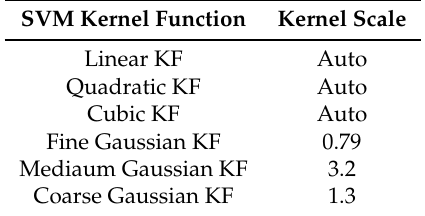
Table 2. Kernel Scale of support vector machine (SVM) models.